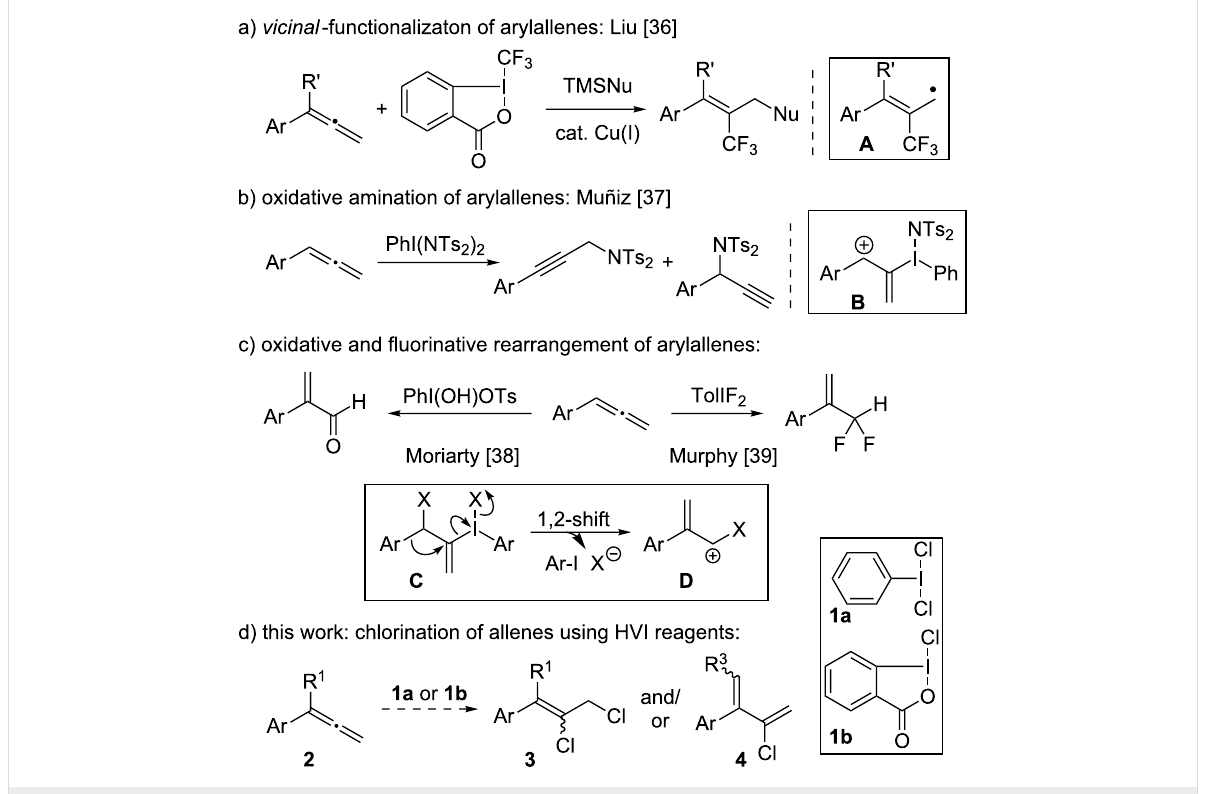
Scheme 1: Reactions of substituted allenes with HVI